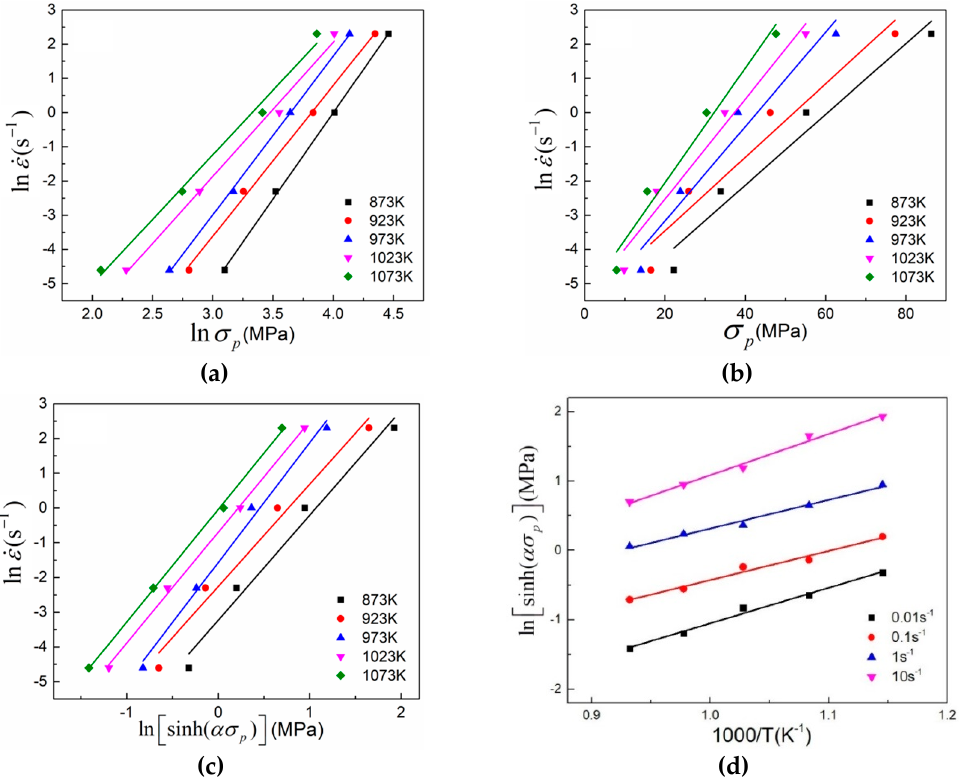
(cid:104) (cid:105) . ε − . ε − σ − ln . ε ln σ p , ( b ) ln sinh ( ασ p ) p , ( c ) ln